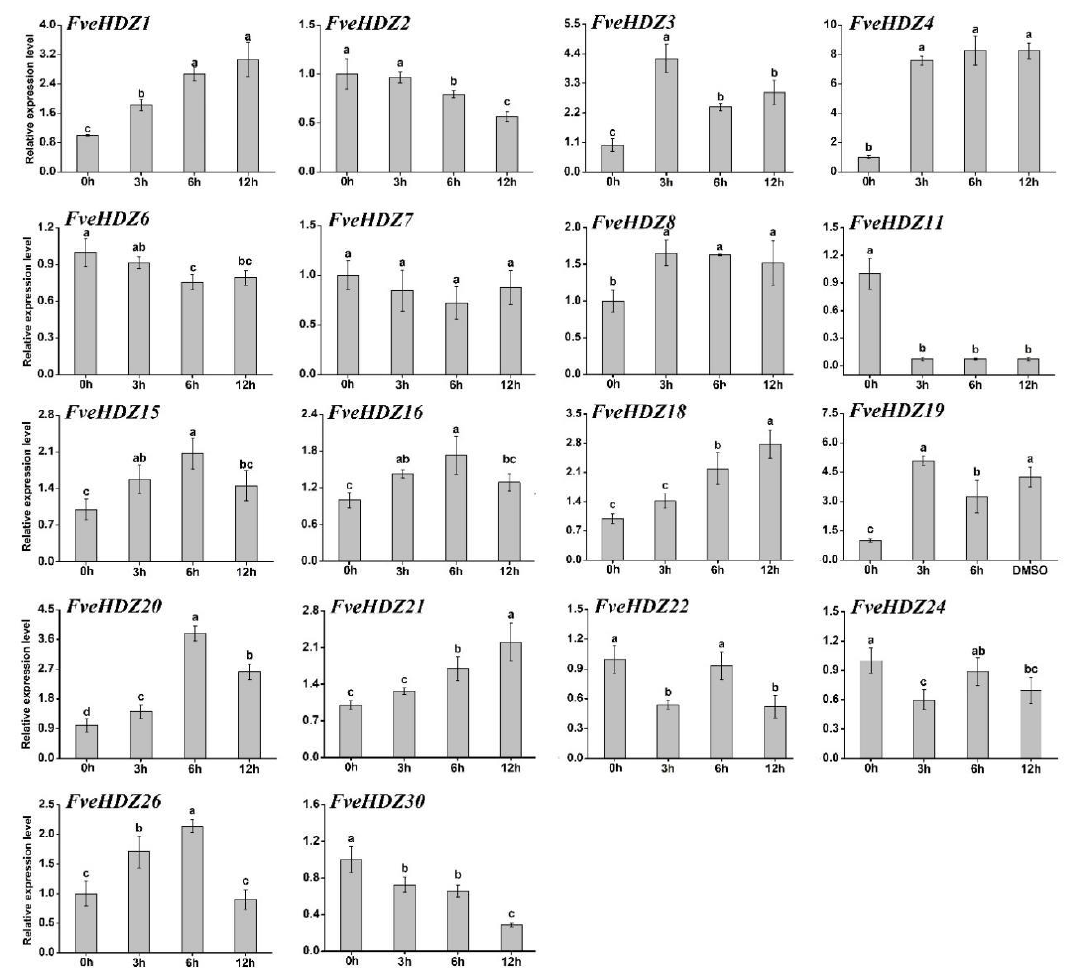
Figure 4. Relative expression levels of FveHDZ genes in leaves under ABA treatment. Expression at 0 h was normalized as “1” and used as control for each gene. Data were shown as mean ± standard deviation derived from three biological replicates, and different letters above the bars indicate significant differences based on Duncan’s multiple range tests ( p < 0.05, n = 3).